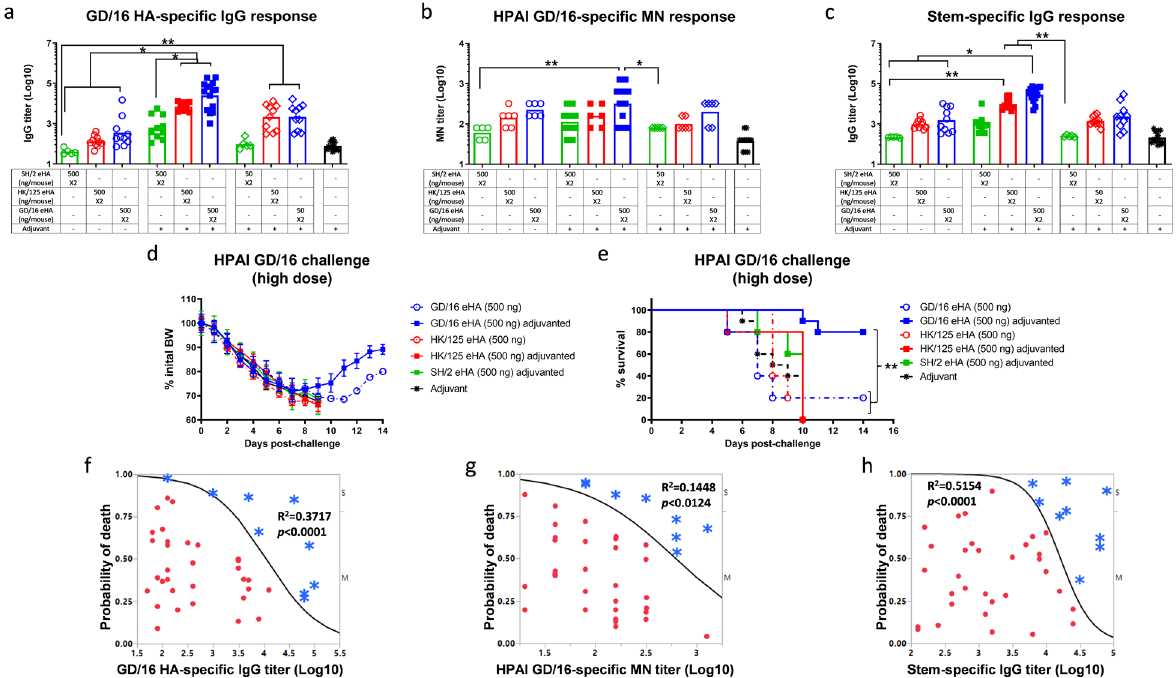
Fig. 3 Immunogenicity and protection against highly pathogenic avian in fl uenza H7N9 virus of the fi fth wave. BALB/c mice were immunized with HA extracted (eHA) from H7N9 candidate vaccine viruses A/Shanghai/2/2013 (SH/2), A/Hong Kong/125/2017 (HK/125), or A/ Guangdong/17SF003/2016 (GD/16) with or without adjuvant. Immunized mice were challenged with highly pathogenic avian in fl uenza (HPAI) wild type (wt) GD/16 virus at 5 × 10 7 TCID 50 /50 µl/mouse (high dose) in a BSL-3 + biocontainment. ( a ) IgG ELISA titers against GD/16 HA; ( b ) microneutralization (MN) titers against HPAI wt GD/16 virus; ( c ) Group 2 HA stem-speci fi c IgG ELISA titers. ( d ) body weight (BW) and ( e ) survival after HPAI wt GD/16 challenge; ( f ) correlation of HA-speci fi c IgG ELISA titers with survivals; ( g ) correlation of MN titers with survivals; ( h ) correlation of HA group 2 stem-speci fi c IgG ELISA titers with survivals. Individual titers with geometric mean (bars) are shown ( n = 5-15 mice/ group). BW data are expressed as mean ± s.e.m ( n = 5 – 10 mice/group). Correlation of antibody titers with mouse survival/mortality statuses after challenge was analyzed using logistic fi t with χ 2. Individual p values and R 2 values are shown. Red dots indicate mortality (M) and blue asterisks indicate survival (S). * p < 0.05 and ** p < 0.01 by Kruskal – Wallis test with Dunn ’ s multiple comparisons after log transformation (antibody responses) or by Log-rank (Mantel – Cox) test (survival